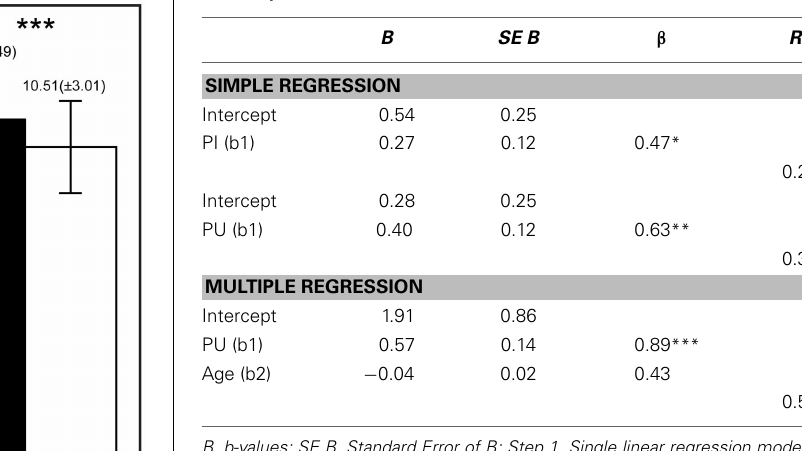
Table 2 | Simple and multiple linear regression analyses of the TUG.